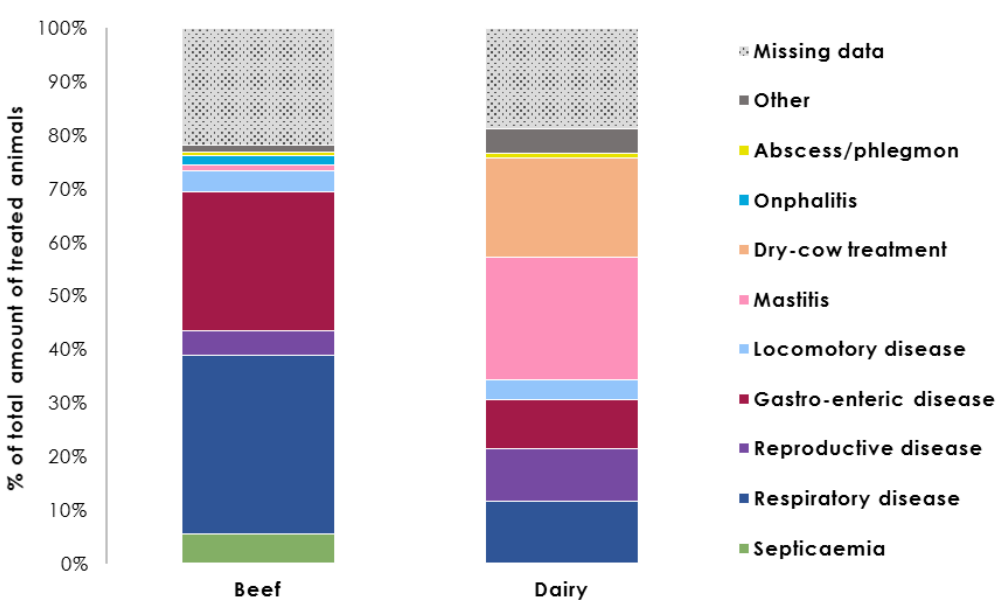
Figure 2. Percentage distribution of treated animals during a yearlong period per individual reason for treatment on beef and dairy cattle farms (for details see Appendix A, Table A3).